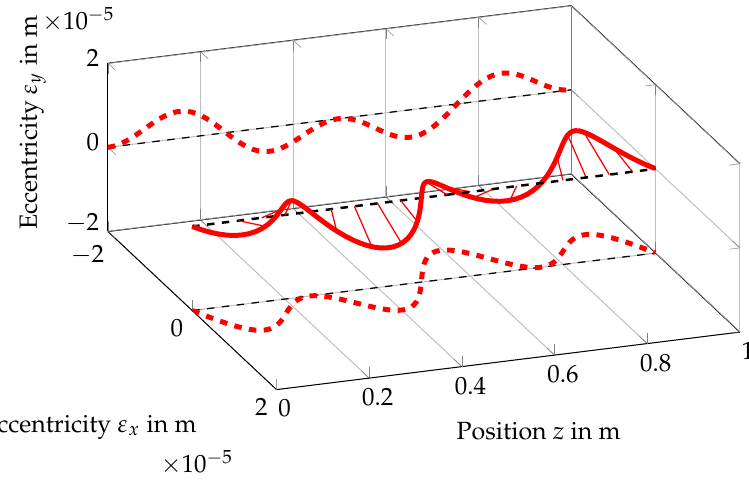
Figure 8. Distributed eccentricity, case B.